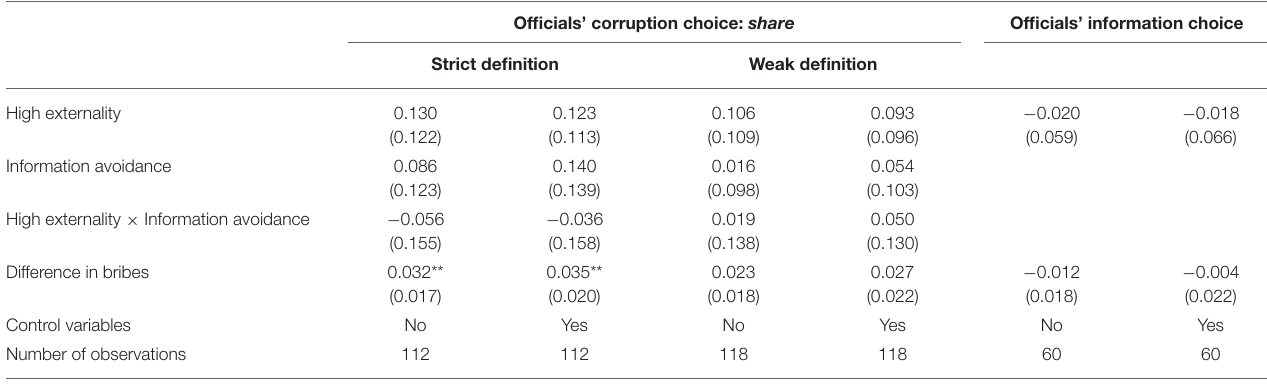
TABLE 3 | Regression analysis on public officials’